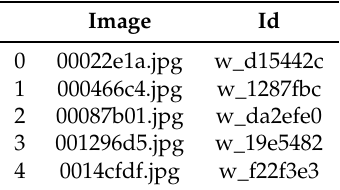
Table 3. Header of the training